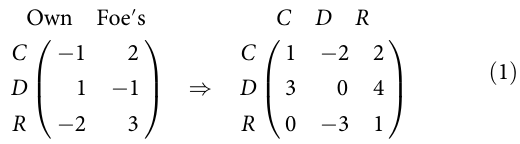
span are drawn as